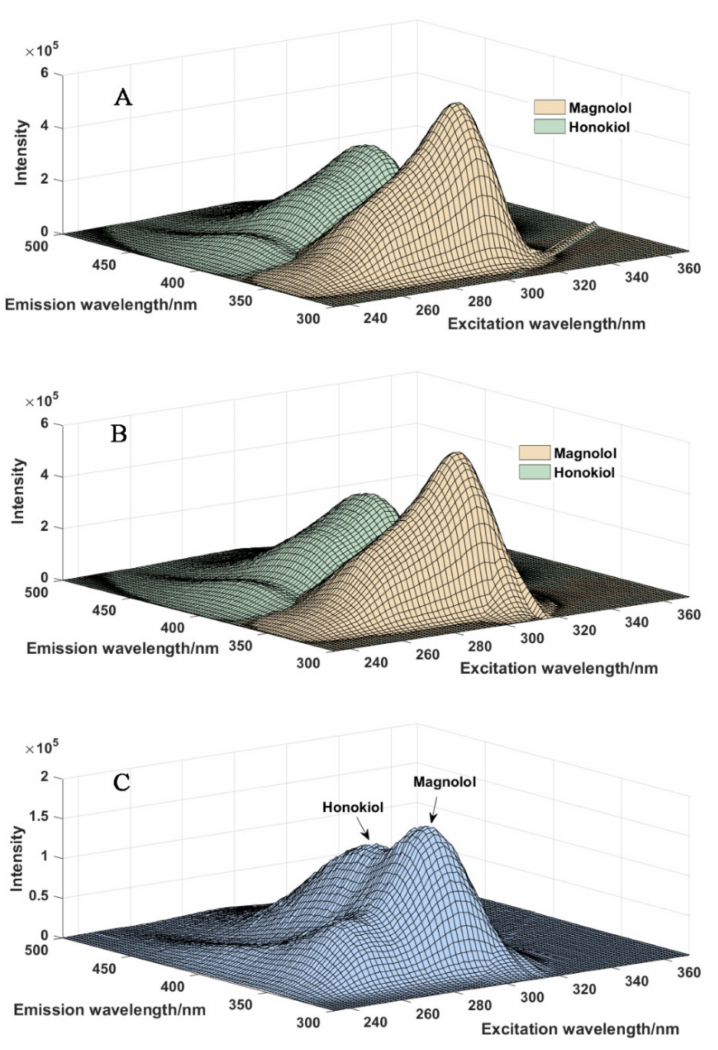
Figure 2. The EEM spectra for pure magnolol and honokiol with scatterings ( A ), without scatterings ( B ), and Magnoliae Cortex ( C